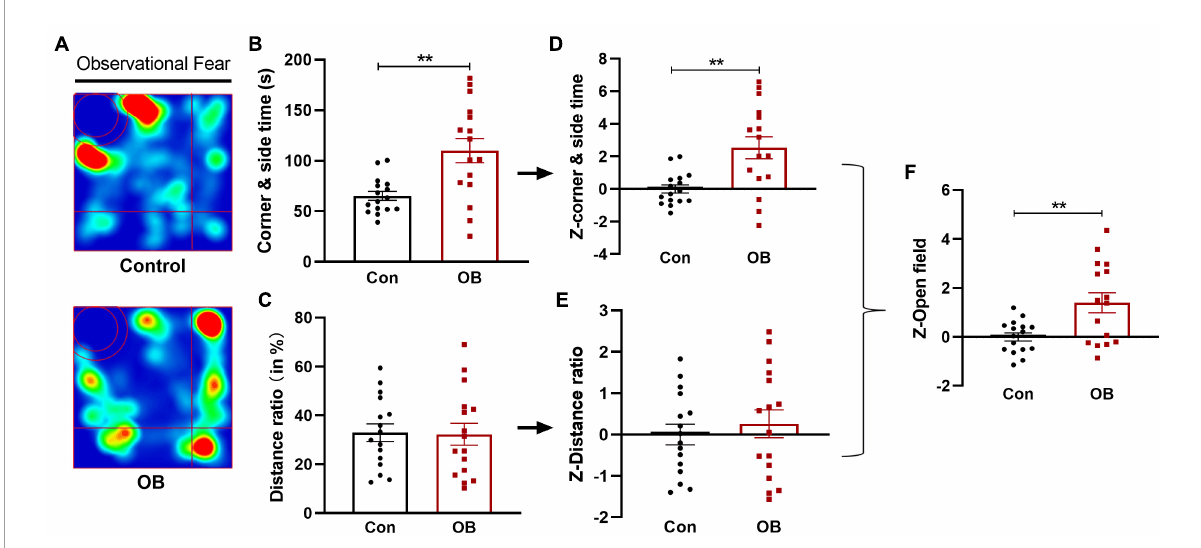
FIGURE3 Avoidance behavior and emotionality Z -scores in open field (OF) test. (A) Representative locomotor path of mice in the two groups in the observational fear training stage. (B) Mice in the model group spent significantly more time in the corner and side than the control group. (C) No significant difference in distance moved in the corner and side area (%). (D,E) Normalization of Z -score for the two parameters with the same statistical P -values. (F) Z-OF calculated by averaging Z -scores of the two OF parameters showed a significant difference between the two groups. Data are expressed as mean ± SEM ( n = 16) and compared by unpaired t -test. ** p < 0.01.